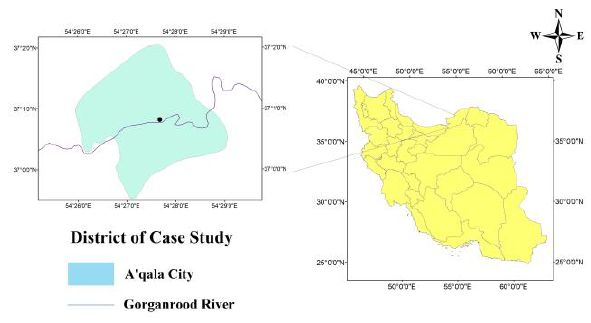
Figure 1. District of Aq'qala city and Gorganrood river